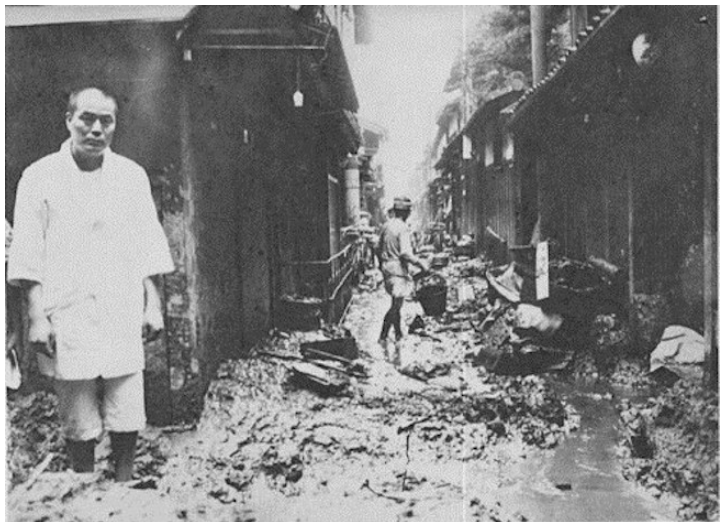
Figure 5. Traditional street Pontocho, 1936 flood. Source: 1936, Flood Report, Kyoto City Hall